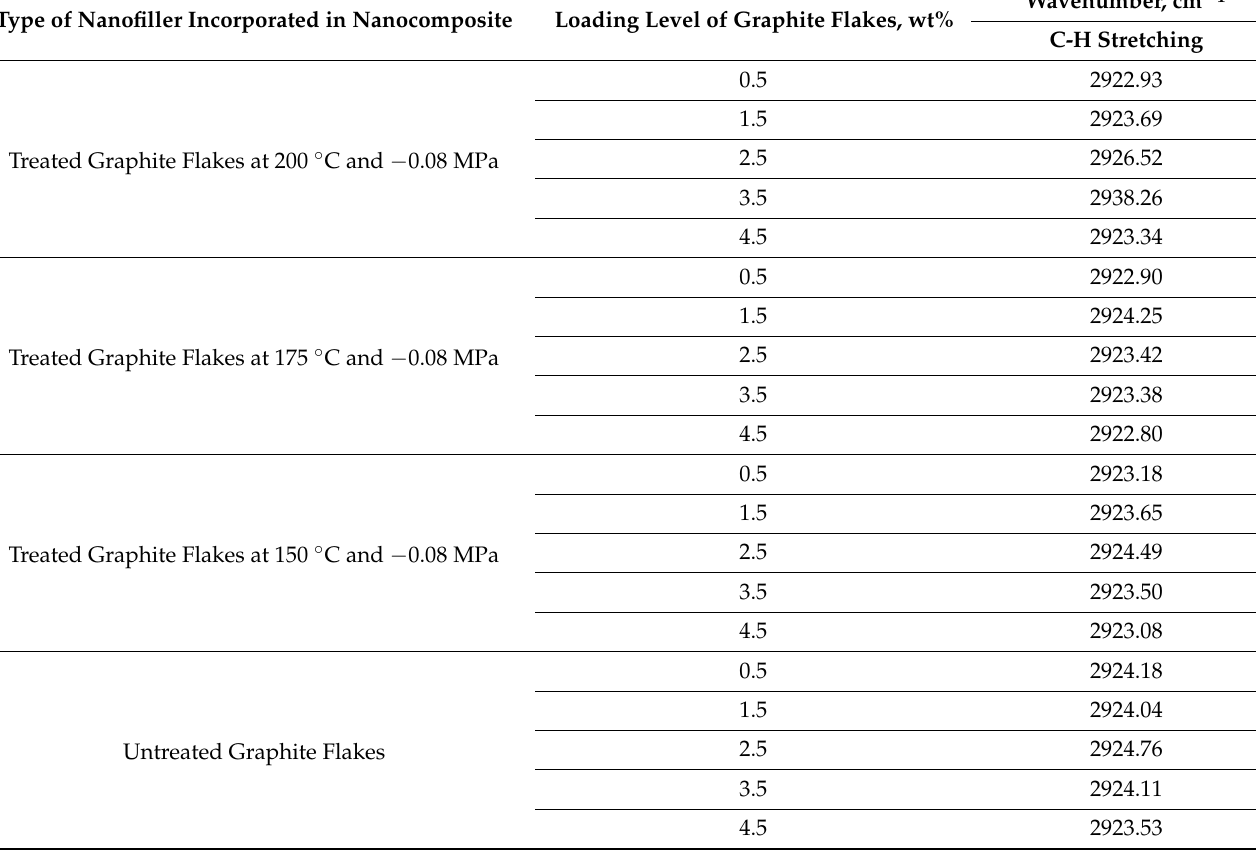
Table 5. Wavenumbers of C-H Stretching Type for All of the Nylon 610/Graphite Flake